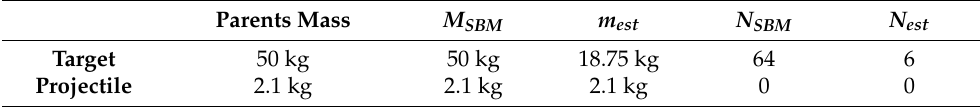
Table 7. Comparison between standard-SBM and iterative-SBM for real test